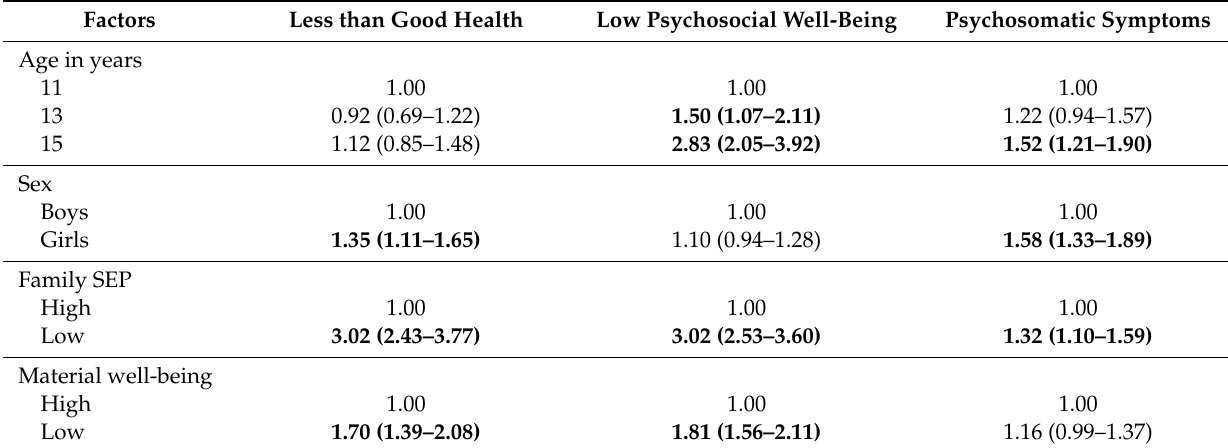
Table 3. Odds ratios (95% confidence interval) of poor health outcomes by di ff erent demographic and socioeconomic characteristics.